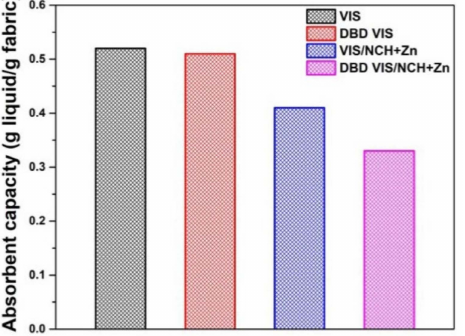
Figure 6. Absorbent capacities of unmodified and DBD-modified viscose fabrics before and after functionalization with NCH+Zn. Part of results previously published in